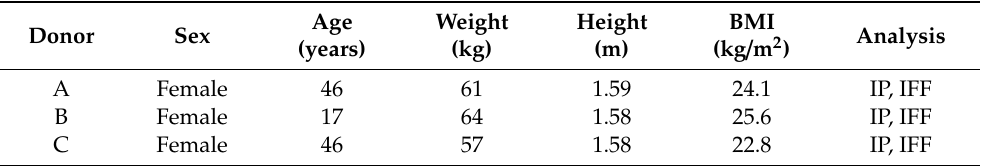
Table 1. Sex, age, weight, height and body mass index (BMI) of the donors of adipose tissue used in this